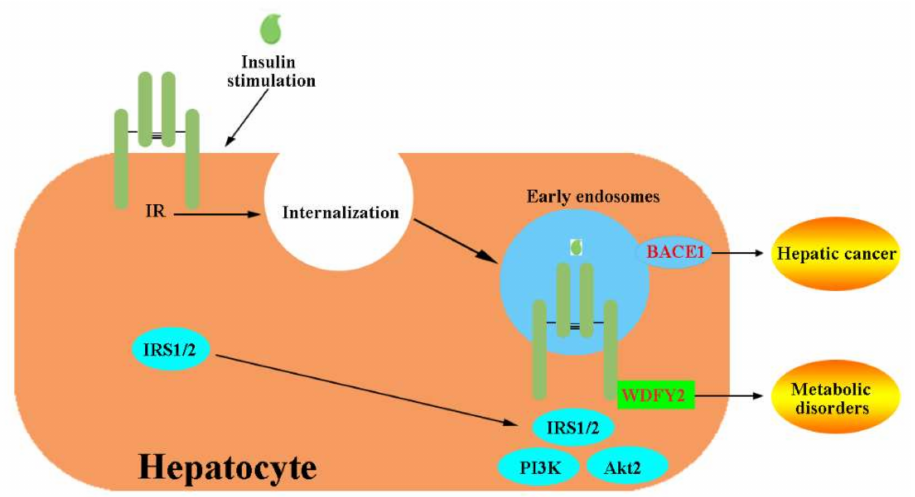
Figure 9. Model for the role of WDFY2 and BACE1 in IR internalization into endosomes in hepato- cytes. After insulin stimulation, the IR internalizes into endosomes. WDFY2 interacts with the IR to localize it to endosomes such that downstream IRS1/2 and AKT2 can be recruited to the endosomal IR. BACE1, located at the early endosomes, cleaves the IR-ECD and decreases the number of mature IRs. WDFY2, WD Repeat and FYVE domain containing 2; BACE1, β -site amyloid precursor protein cleaving enzyme